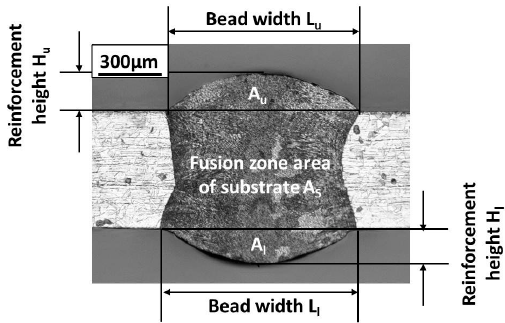
Figure 2. Cross ‐ section of weld bead of pulsed laser welding with filler wire. Figure 2. Cross-section of weld bead of pulsed laser welding with filler